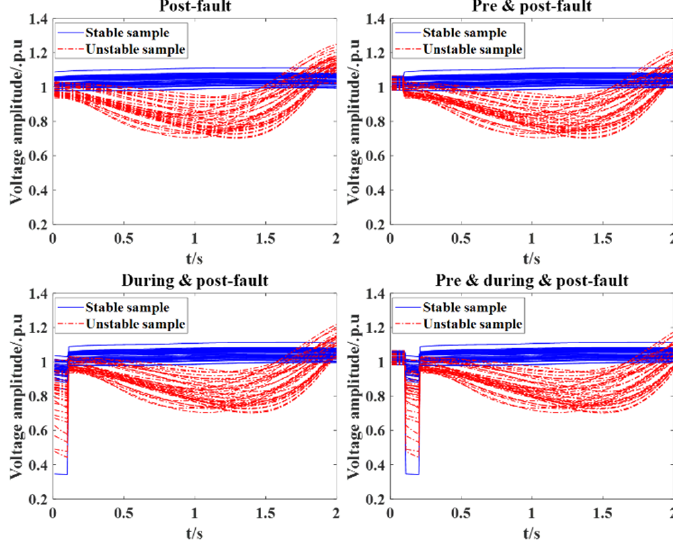
Figure 4. Voltage curves of all buses for the four-sampling series.